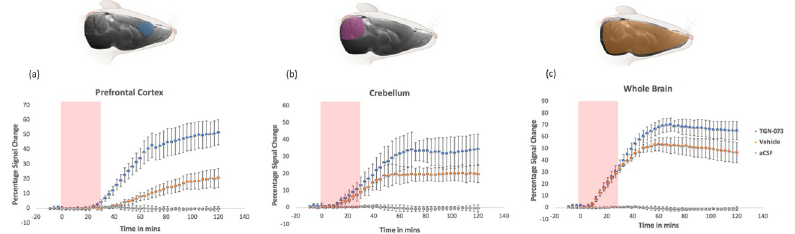
Fig 4. Averaged time activity curves (TAC) of three different regions of rats’ brains. The percentage signal change is plotted as a function of time for theTGN-073 treated (n = 6, blue circles), vehicles (n = 6, orange circles), and artificial CSF (n = 3, grey circles) in (a) prefrontal cortex, (b) cerebellum and (c) whole brain. Pink shading on graphs indicates the period of tracer infusion. Shading on the anatomical images of the brain illustrates the location of ROIs, blue: prefrontal cortex, purple: cerebellum and orange: whole